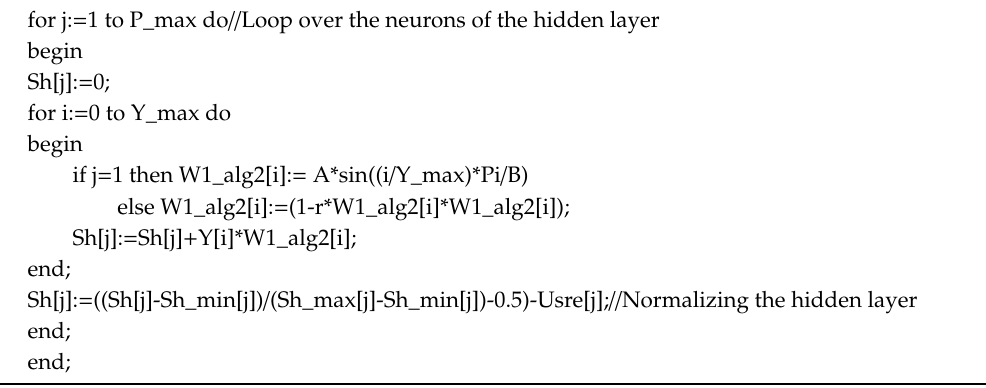
Algorithm A6.2. Algorithm 2.